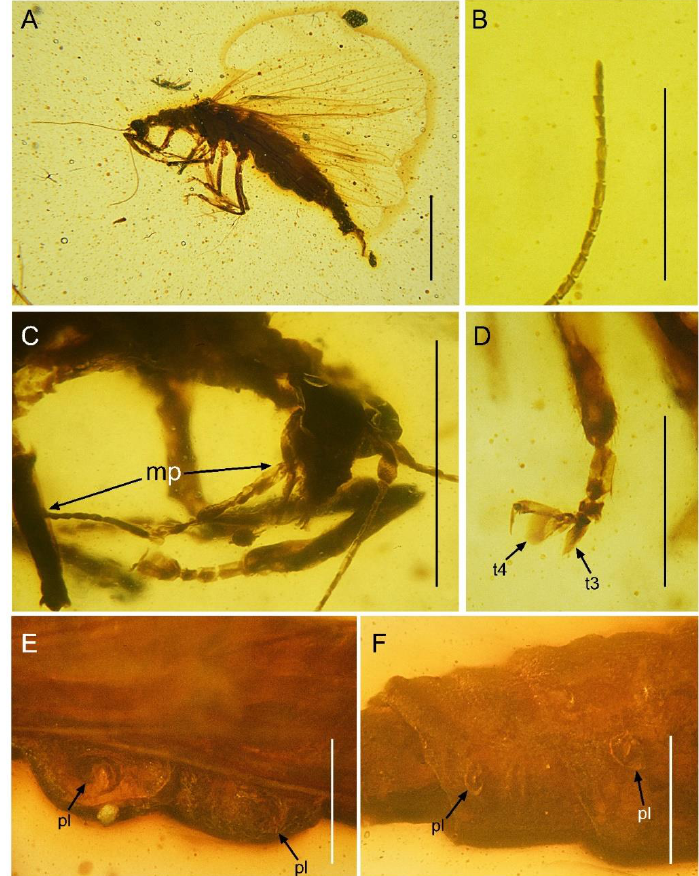
Figure 5. Paradoxoconis longipalpa gen. et sp. nov. , holotype: BXAM BA-NEU-010. ( A ) Habitus, lateral view; ( B ) apical flagellomeres; ( C ) head, lateral view; ( D ) metatarsus; ( E ) plicatures on left side of abdomen; ( F ) plicatures on right side of abdomen. Abbreviation: mp, maxillary palpus; t, tarsomere; pl, plicature. Scale bar = 1.0 mm ( A ); 0.5 mm ( C ); 0.25 mm ( B , D , E , F ).